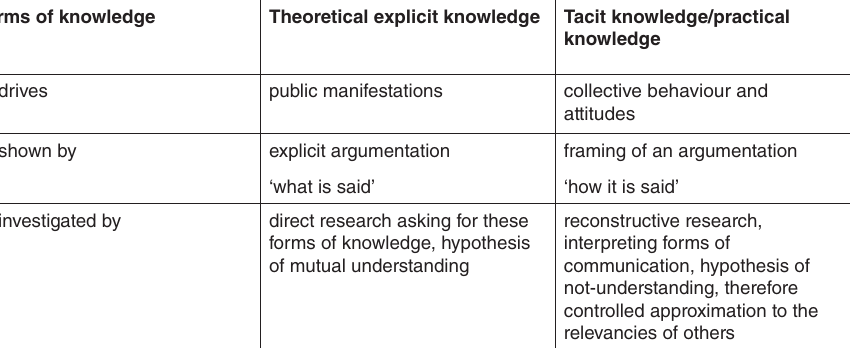
Table 1: Forms of knowledge and their relation to different forms of